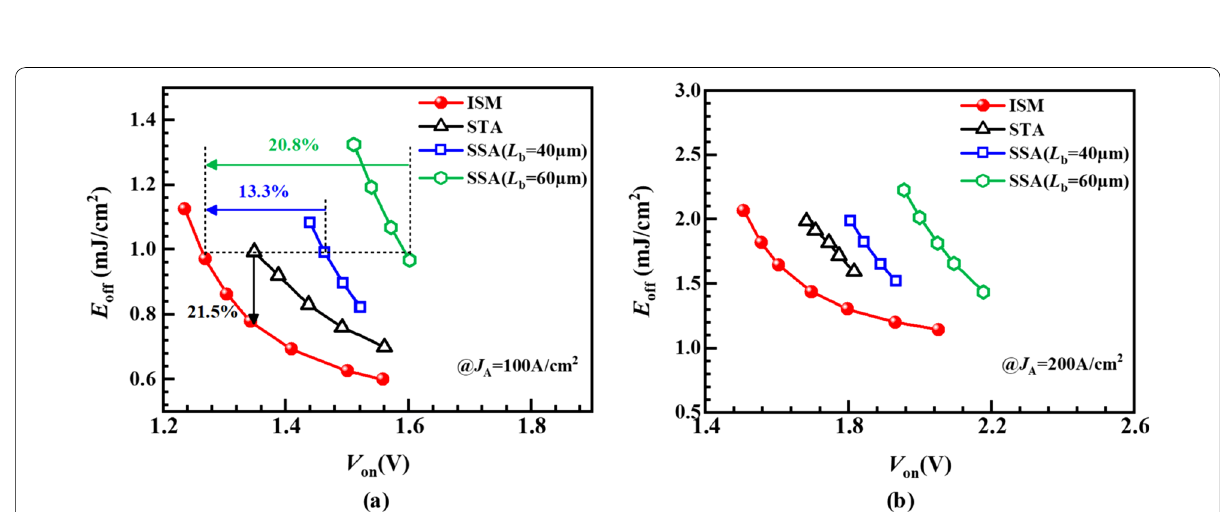
Fig. 8 E off versus V on for different LIGBTs: a J A